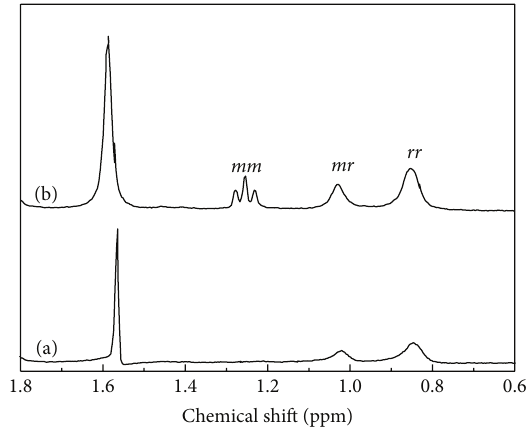
Figure5: 1 HNMRspectraof a -CH 3 ofPMMAinCDCl 3 forPMMA synthesized with PE-TEMPO-Q, (a) Table 1, run 10; (b) Table 1,